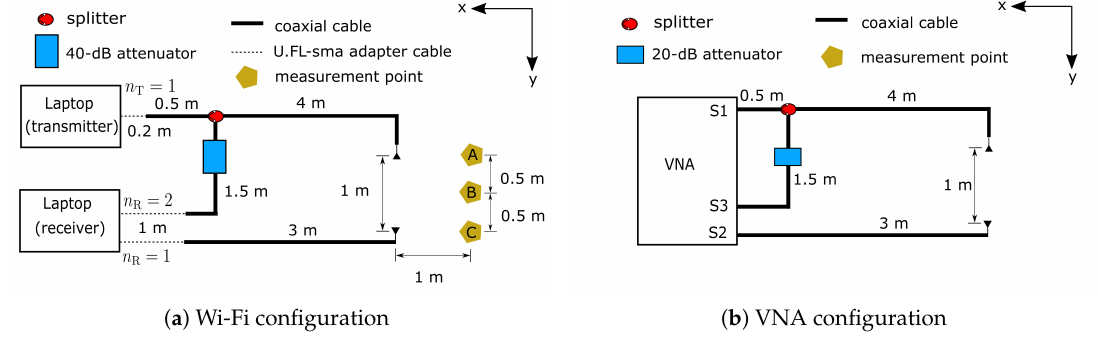
Figure 7. Physical configuration of the measurement